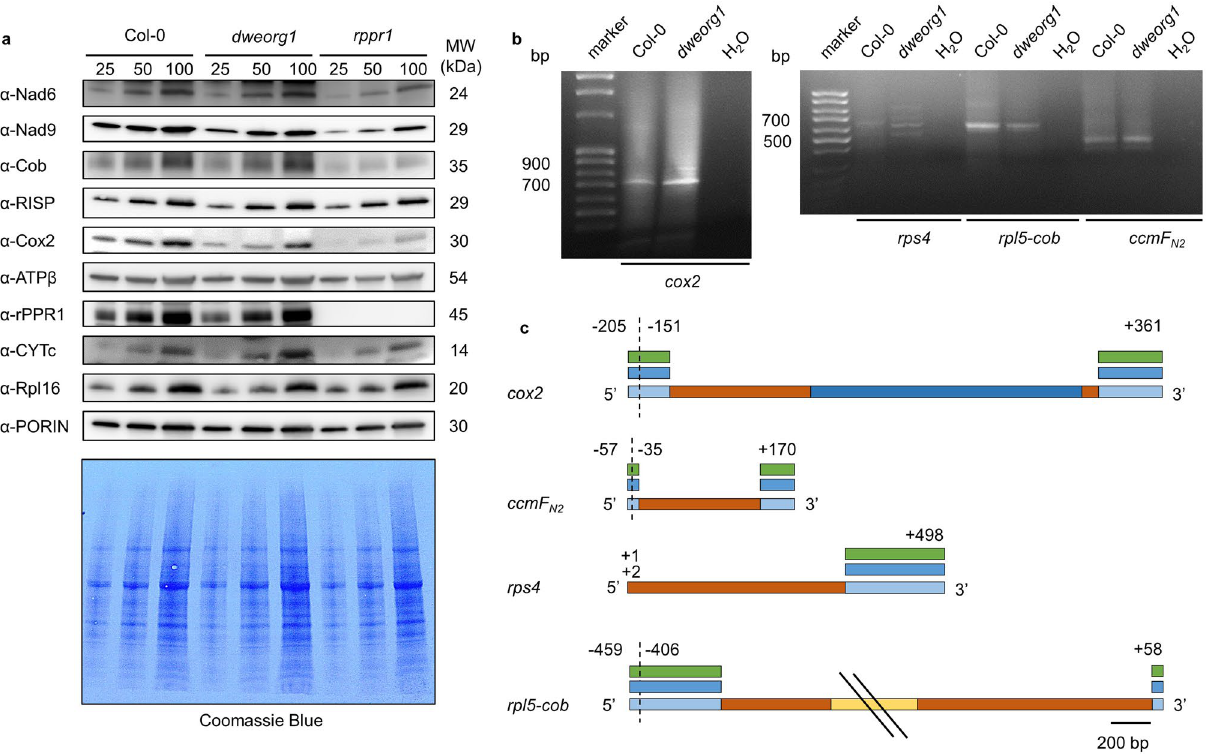
Figure 4. The dweorg1 mutant accumulates slightly reduced levels of the Cox2 and Nad9 proteins. 5 ′ and 3 ′ termini processing for cox2 , rps4 , rpl5 , and ccmF N2 is not affected in dweorg1 . ( a ) Immunoblot analysis comparing the steady-state levels of selected mitochondria-encoded (Nad9, Cox2, Rpl16, ATPβ) and nuclear- encoded (RISP, rPPR1, CYTc) mitochondrial proteins in wild type, dweorg1 , and rppr1 mutants. PORIN was used as a loading control; 25, 50, and 100 µg of total proteins were used in each lane, as indicated. The molecular weight of the respective proteins is given in kDa. Original, full-length blots are presented in Supplementary Fig. S10. ( b ) cRT-PCR analysis amplifying the 5 ′ and 3 ′ termini of cox2 , rps4 , rpl5-cob , and ccmF N2 transcripts. Total RNAs were extracted from the indicated genotypes, circularized, and then used for cDNA synthesis prior to PCR amplification using divergent primers near the mRNA extremities. The obtained PCR amplification products were run on the shown agarose gel. H 2 O was used for PCR water control. Original, full-length gels are presented in Supplementary Fig. S11. ( c ) Illustration of the determined 5 ′ and 3 ′ termini of cox2 , rps4 , rpl5- cob , and ccmF N2 in wild type and dweorg1 mutant plants via cRNA analysis, quantitative RT-PCR, and reverse transcription PCR. Depicted is the structure of cox2 , rps4 , rpl5-cob , and ccmF N2 mRNA, exons being shown as orange boxes, introns as dark blue boxes, intergenic regions (not to scale) as yellow boxes, and the 5 ′ and 3 ′ termini as light blue boxes. The 5 ′ and 3 ′ termini are shown as identified in 24